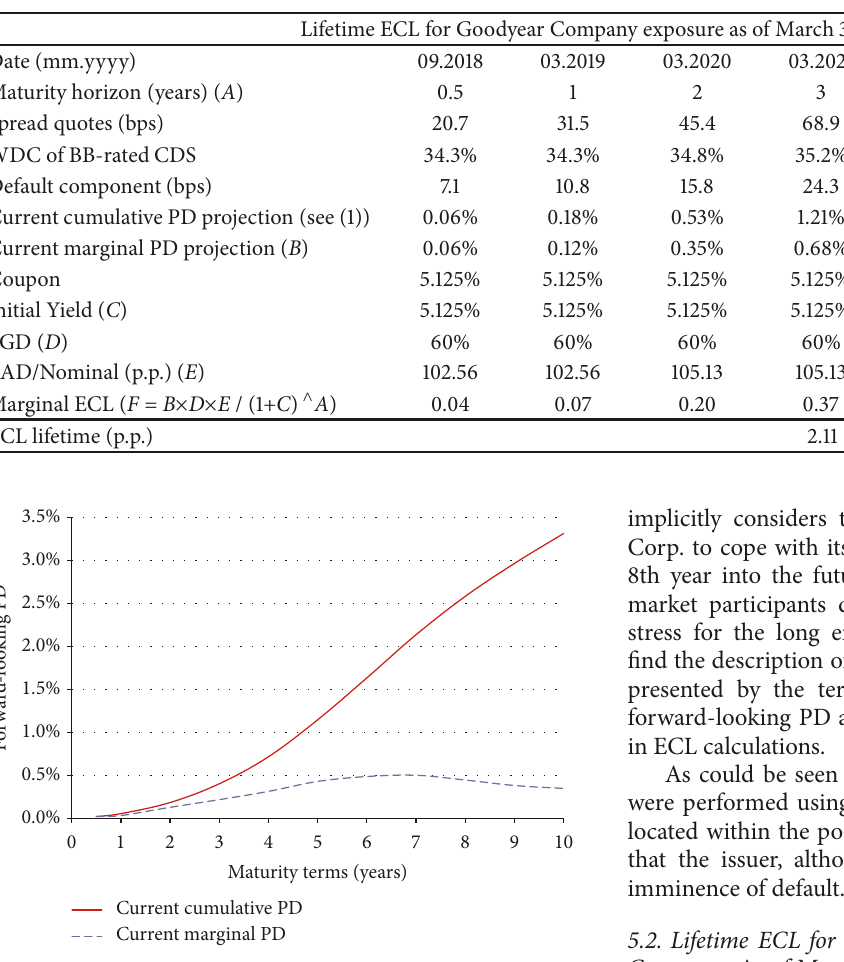
Figure 5: CBS Corp default risk structure: current PD